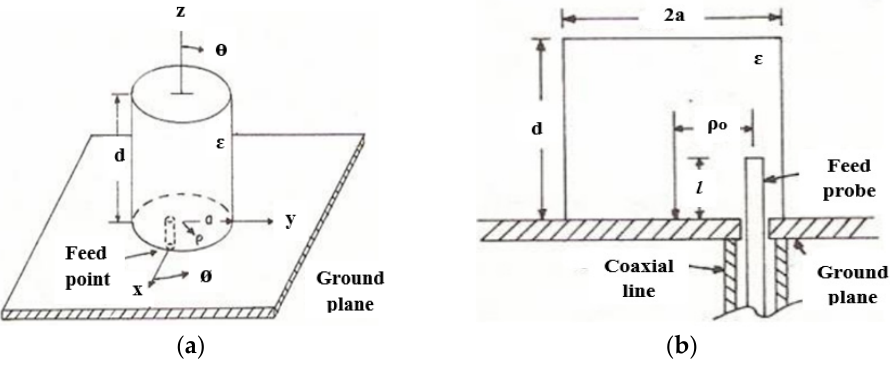
Figure 1. Cylindrical DRA: ( a ) full geometry; ( b ) feed configuration [15].